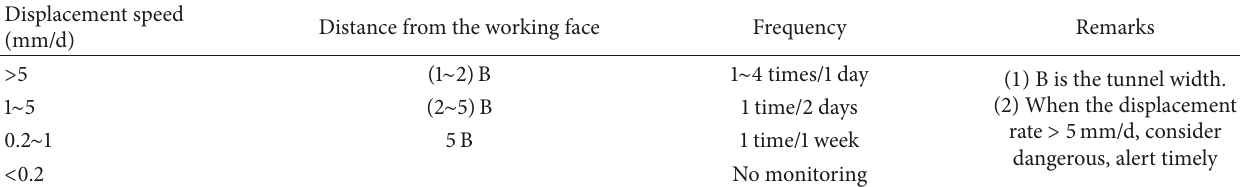
Table 2: Frequency of convergence displacement